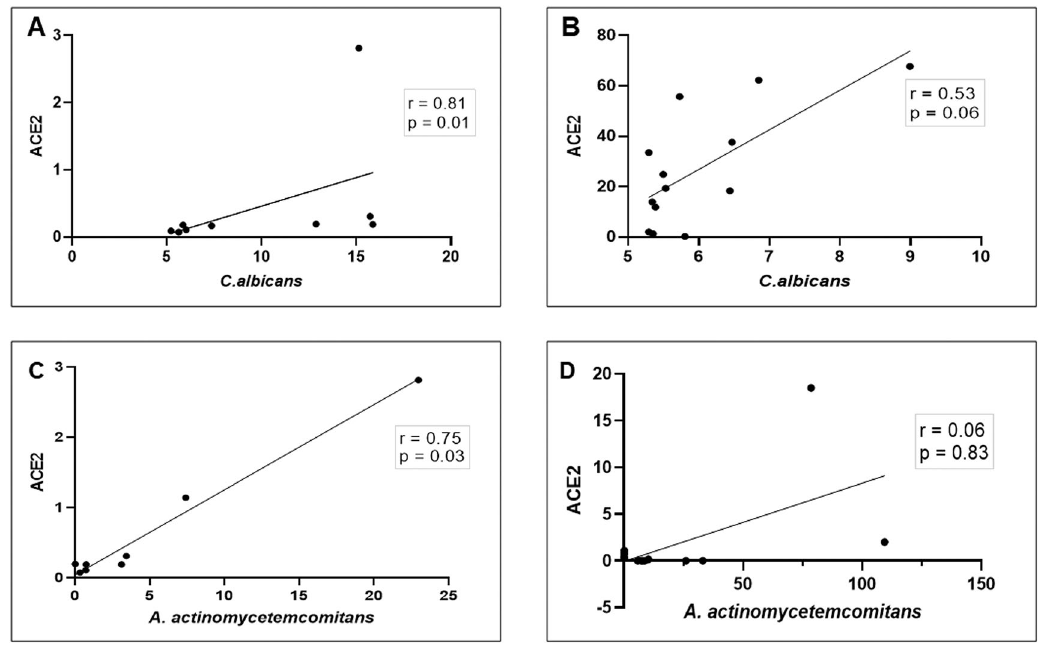
Figure 4. Scatter diagram illustrating the correlation between mRNA expression of ACE2 and C. albicans / A. actinomycetemcomitans in patients with COVID-19 with (DG) and without (NDG) diabetes. These observations indicate that in DG, the correlation between ACE2 mRNA expression and the abundance of C. albicans / A. actinomycetemcomitans is strongly positive (A and C), while in NDG the correlation is weakly positive (B and D). Spearman correlation coefficient (r2) and exact p-values are